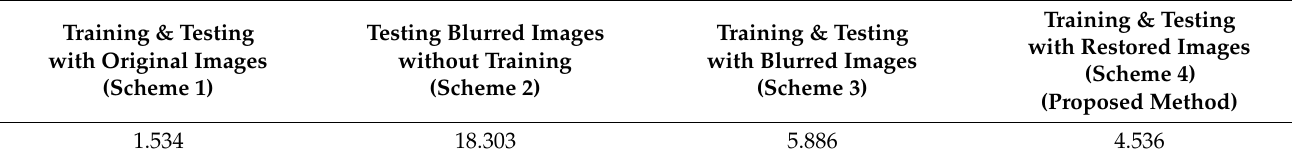
Table 6. Comparison of finger-vein recognition error (EER) with respect to the applicable of a motion blur with PolyU-DB (unit: %).